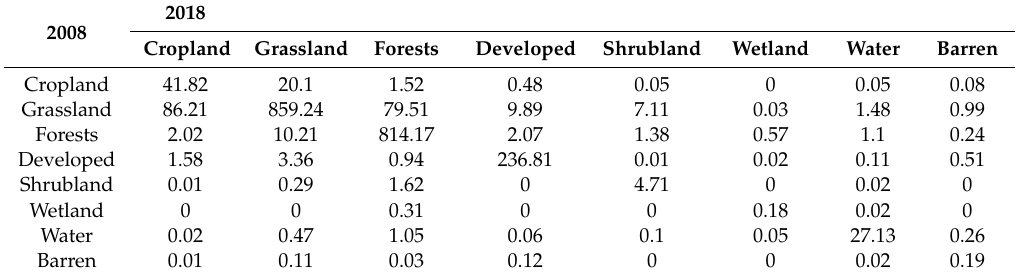
Figure 3. Spatial patterns in land use ( a ) and grassland conversions ( b ) and contributions of different land use types to the grassland shrinkage across the Bluegrass Region ( c ) (the CDL map was reclassified into major land use types). Table 2. Land conversion matrix for the Bluegrass Region from 2008 to 2018 (unit: 1000